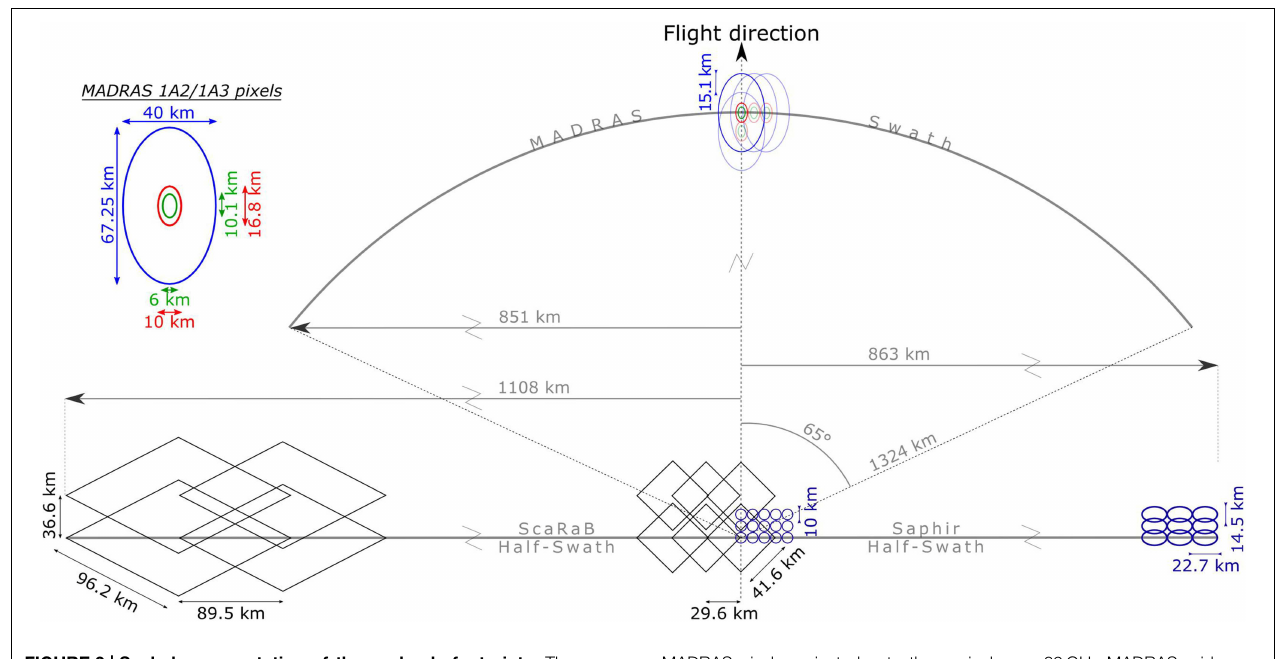
FIGURE 3 | Scaled representation of the payloads footprints. The L1A2 products correspond to brightness temperature of pixels for MADRAS and SAPHIR radiometers based on original L1 samples from the instruments. Note that the L1A2 product for Scarab is identical to L1A. L1A3 format correspond to SAPHIR, SCARAB pixels and all